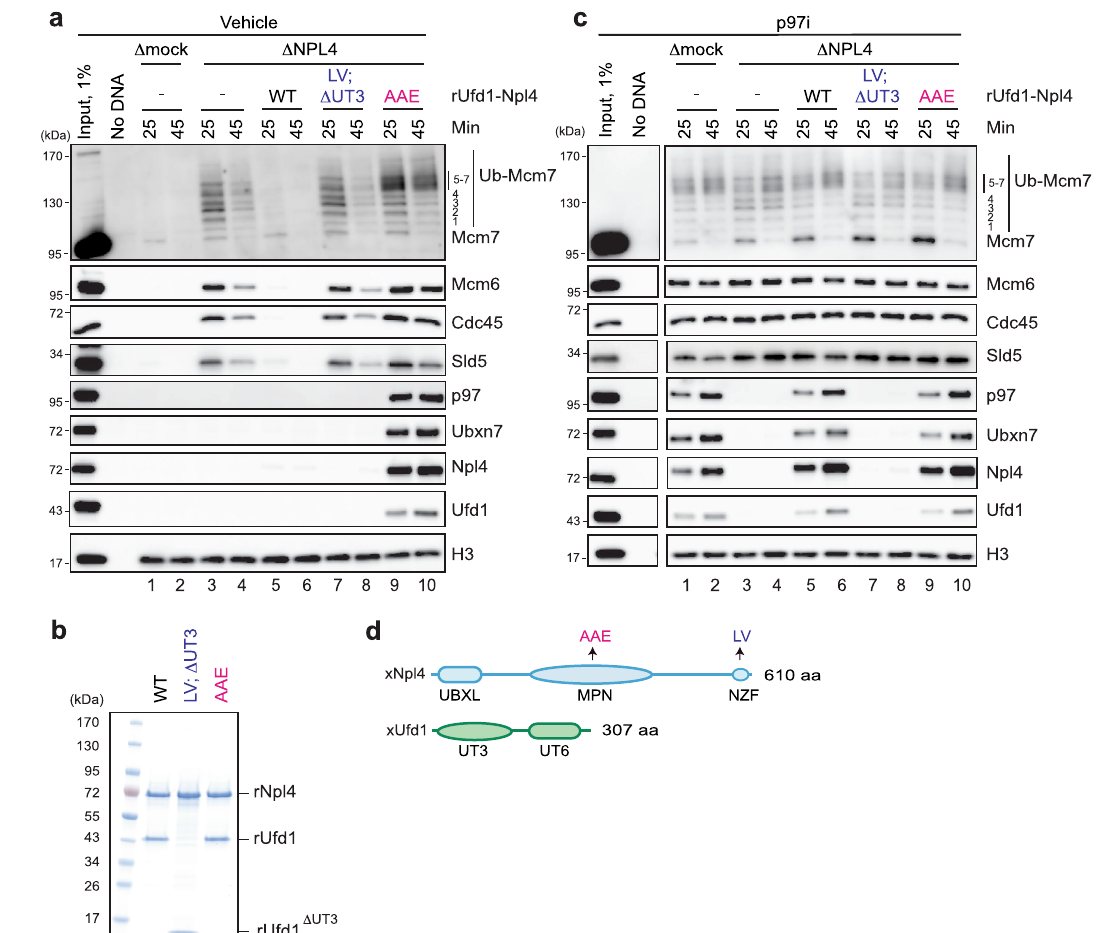
Fig.2|Thep97 Ufd1-Npl4 complexinitiatesCMGunloadingininterphase.a Analysis ofchromatin-boundproteinsinmock-orNpl4-depletedeggextractsintheabsence p97i. Extracts were supplemented with recombinant wild-type or Ufd1-Npl4 mutantsasindicated.At25and45minafterreplicationinitiation,plasmidDNAwas recovered with LacR-coated beads and immunoblotted for the indicated proteins. Δ UT3, deletion of 2-215aminoacidsofUfd1. Ub-Mcm7, ubiquitylatedMcm7. Other abbreviations as in d . See also Supplementary Fig. 2a for mock and Ufd1-Npl4 immunodepletion ef fi ciency. b An image of polyacrylamide gel of recombinant wild-type and mutant variants of Ufd1-Npl4. Abbreviations as in d . c As in a , but extracts were supplemented with p97i. See also Supplementary Fig. 2c for